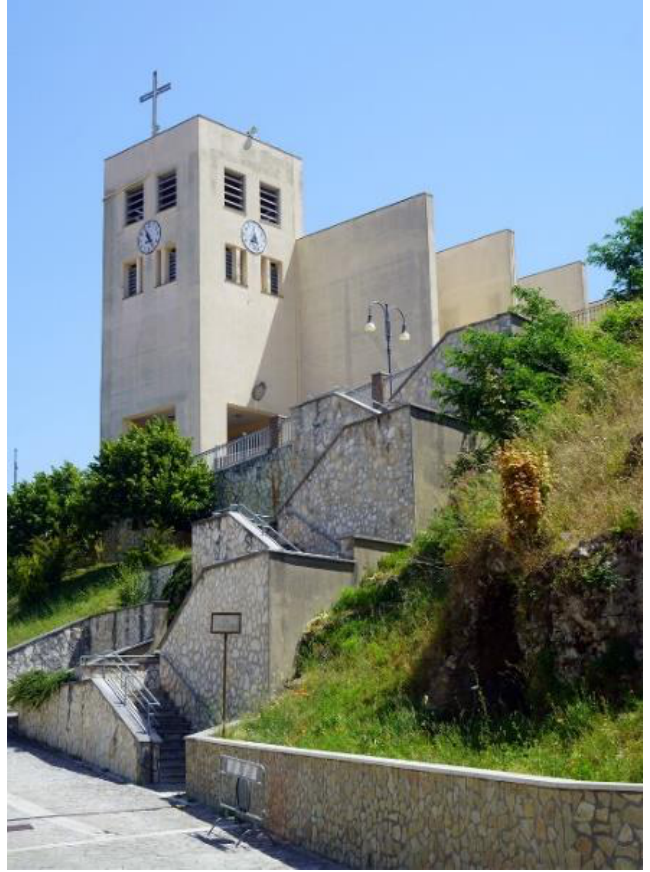
Figure 101. Teora: the new Church of S. Nicola di Mira (photos by